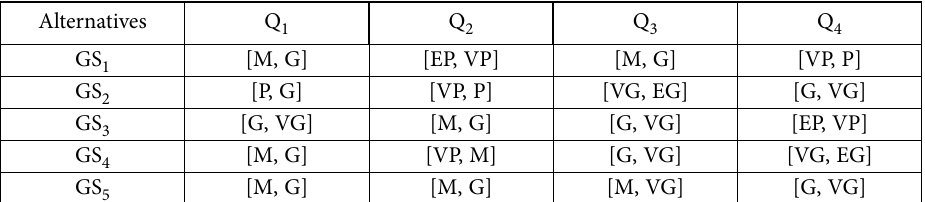
Table 10. The ULTSs through DM 5 Alternatives